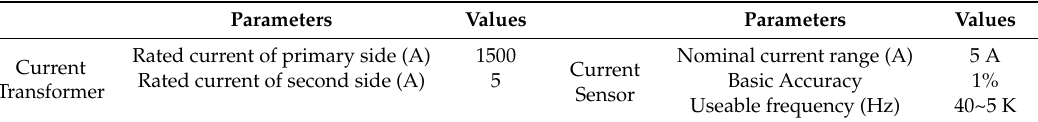
Table 2. The key parameters of the current sensor and current transformer.